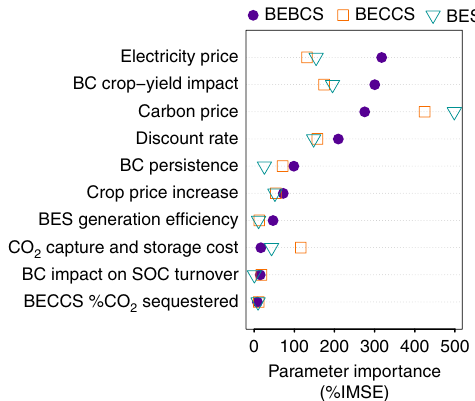
Figure 2 | Parameter importance as determinants of relative present value. The most important parameters for determining the relative present value (RPV) of bioenergy systems (BES; open cyan triangles), bioenergy with carbon capture and storage (BECCS; open orange squares) and bioenergy-biochar systems (BEBCS; filled purple circles). Parameters are ranked in order of importance in determining BEBCS RPV. Parameter importance was determined by random forest analysis incremental mean square error (IMSE). BC, biochar; CCS, carbon capture and storage; SOC, soil organic carbon; and BECCS seq. fraction is the fraction of generated CO 2 that is